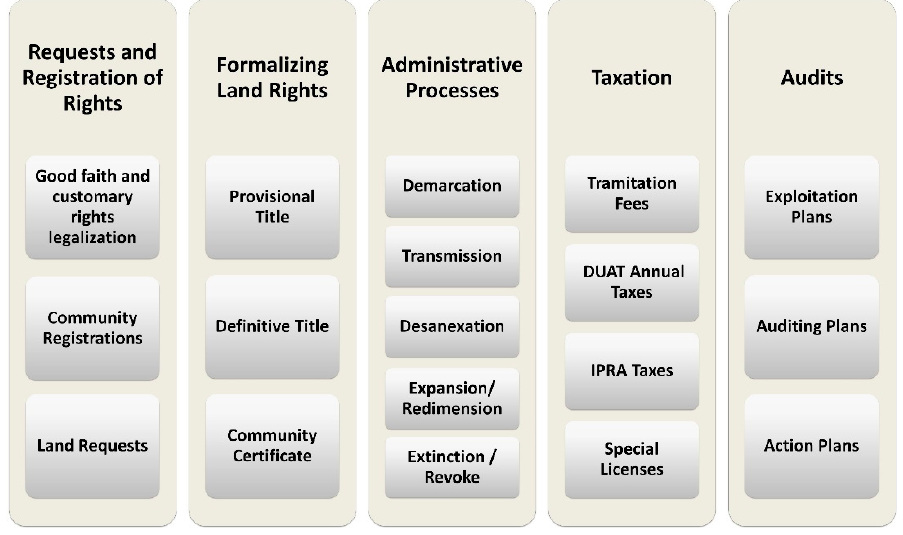
Figure 11. SiGIT Land Information System Business Processes. Source: [37].